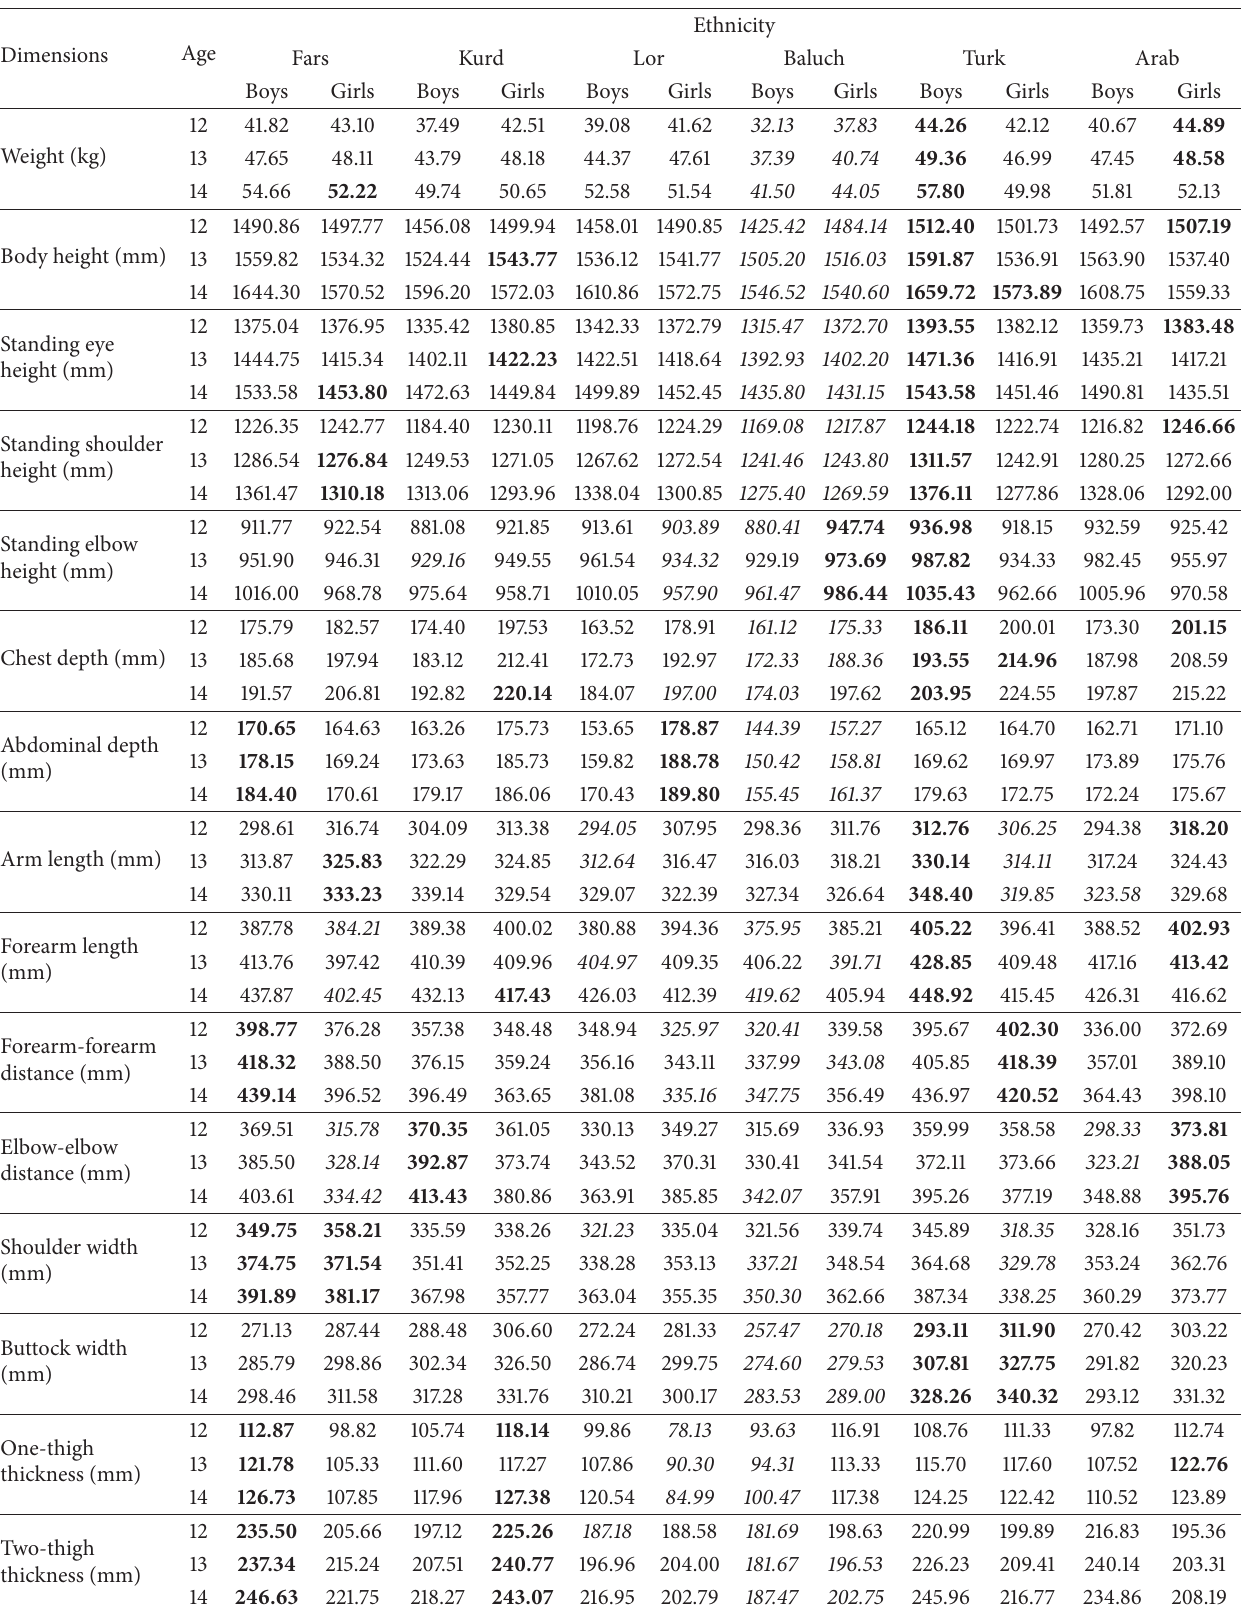
Table 3: Mean anthropometric dimensions in Iranian